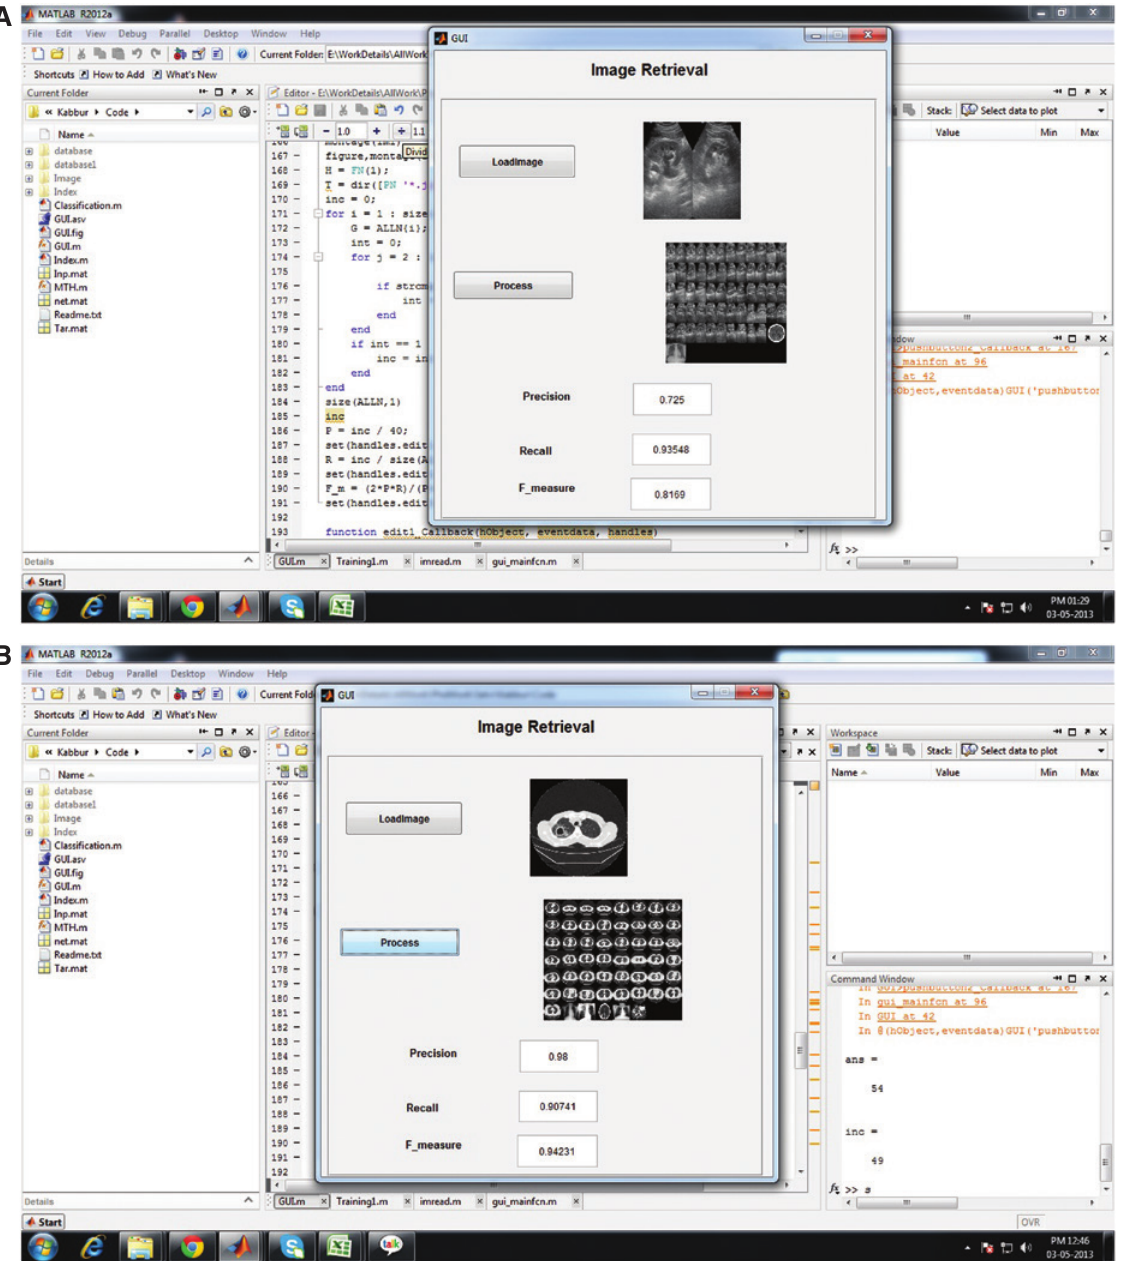
Figure 6: Screenshot for the Entire Proposed